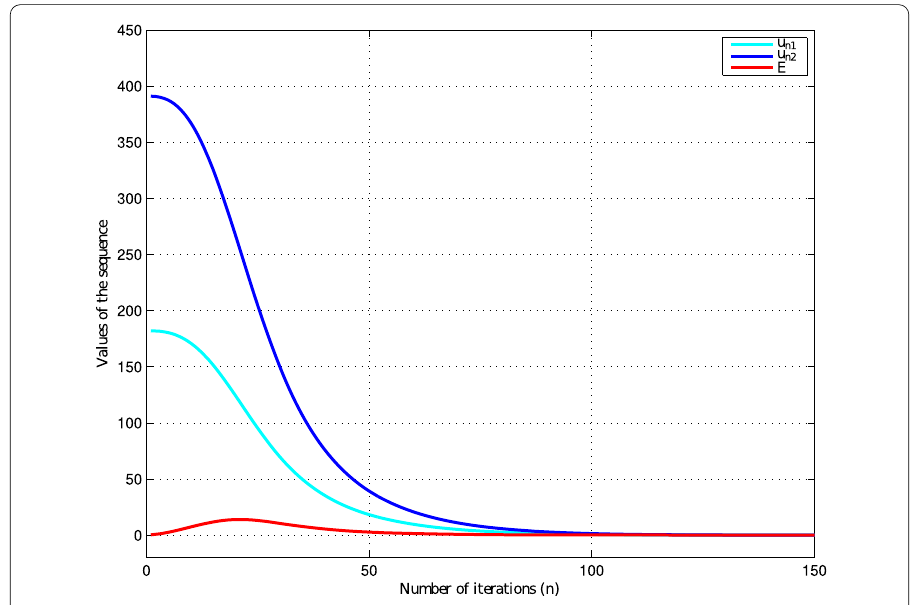
Figure 3 Convergence result of Theorem 3.5 with starting point of Case 3